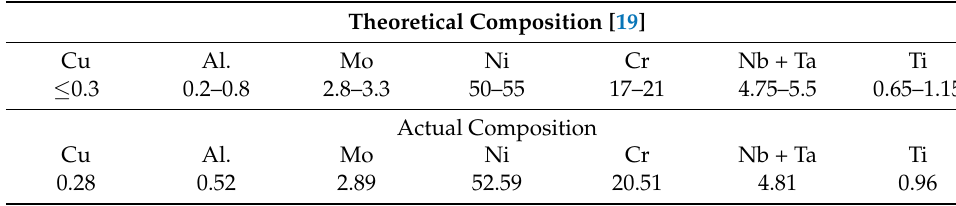
Table 1. Composition of Inconel 718.